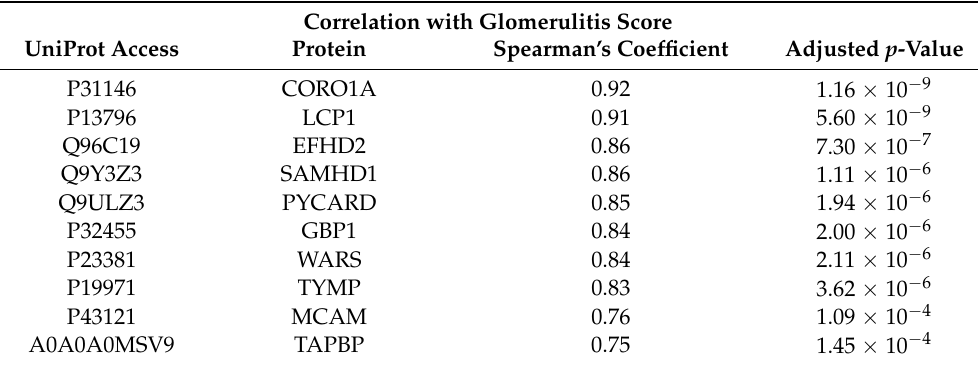
Table 3. Top-10 proteins positively correlated between their abundances by mass spectrometry and the Banff morphological glomerulitis